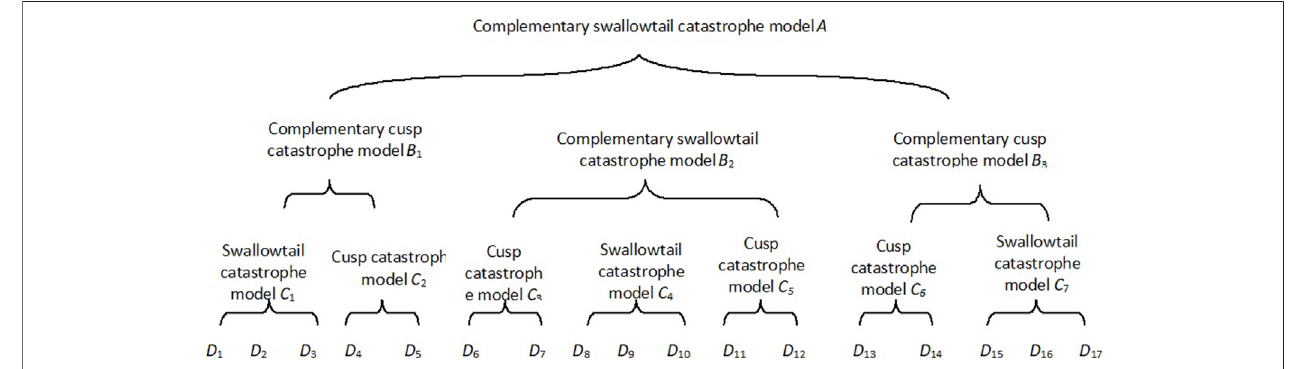
FIGURE 3 | Catastrophe models for assessment of the development level of reclaimed water.